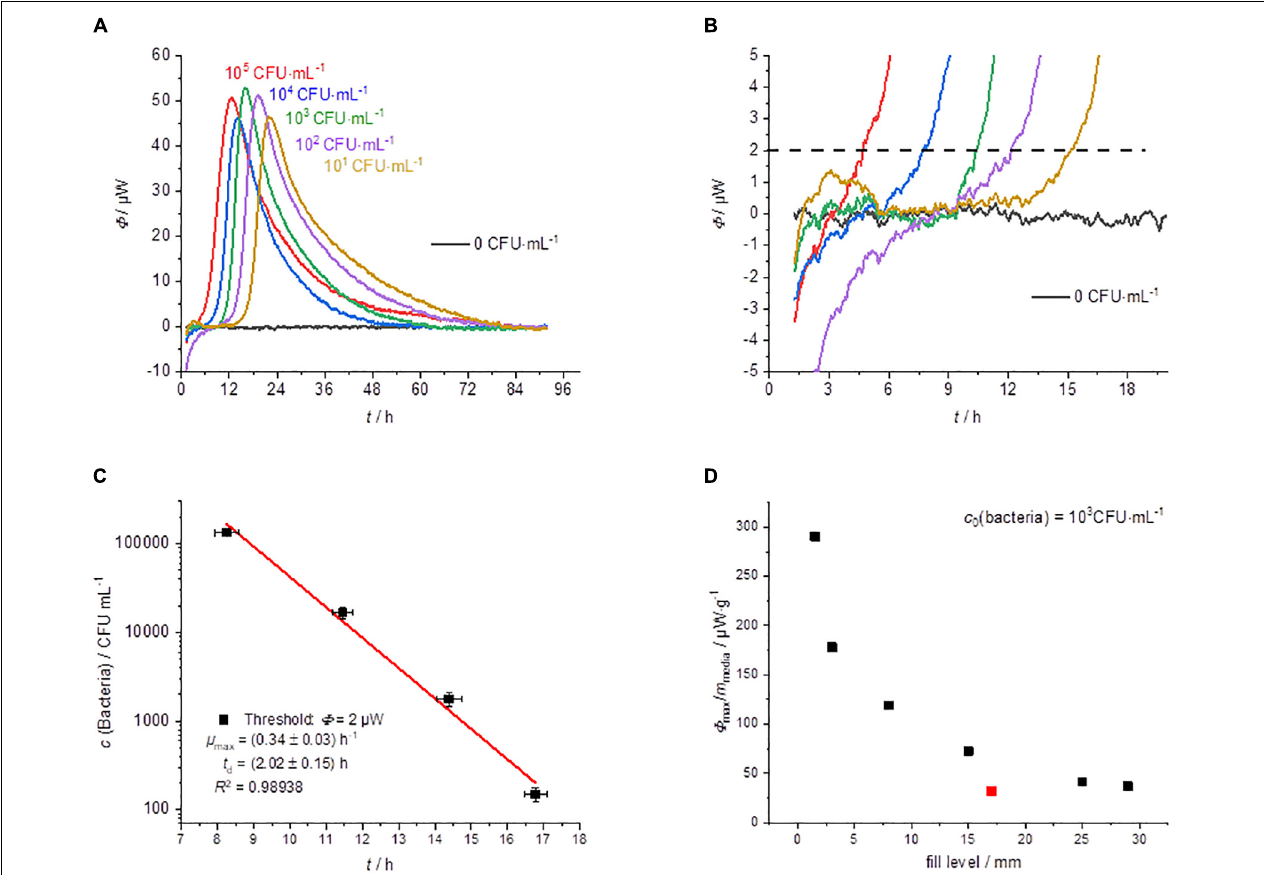
FIGURE 2 | Summary of the IMC experiments performed on MRS-agar (GOA). (A) Dependency of the heat traces on the initial bacterial concentration. (B) Detail magnification of the heat signal near the quantification limit, the dotted line represents the postulated threshold value (cid:56) dect . = 2 µ W. (C) Dependency of the detection time on the initial bacterial concentration. (D) Specific maximum heat flow as a function of the filling level of the calorimetric vessel.